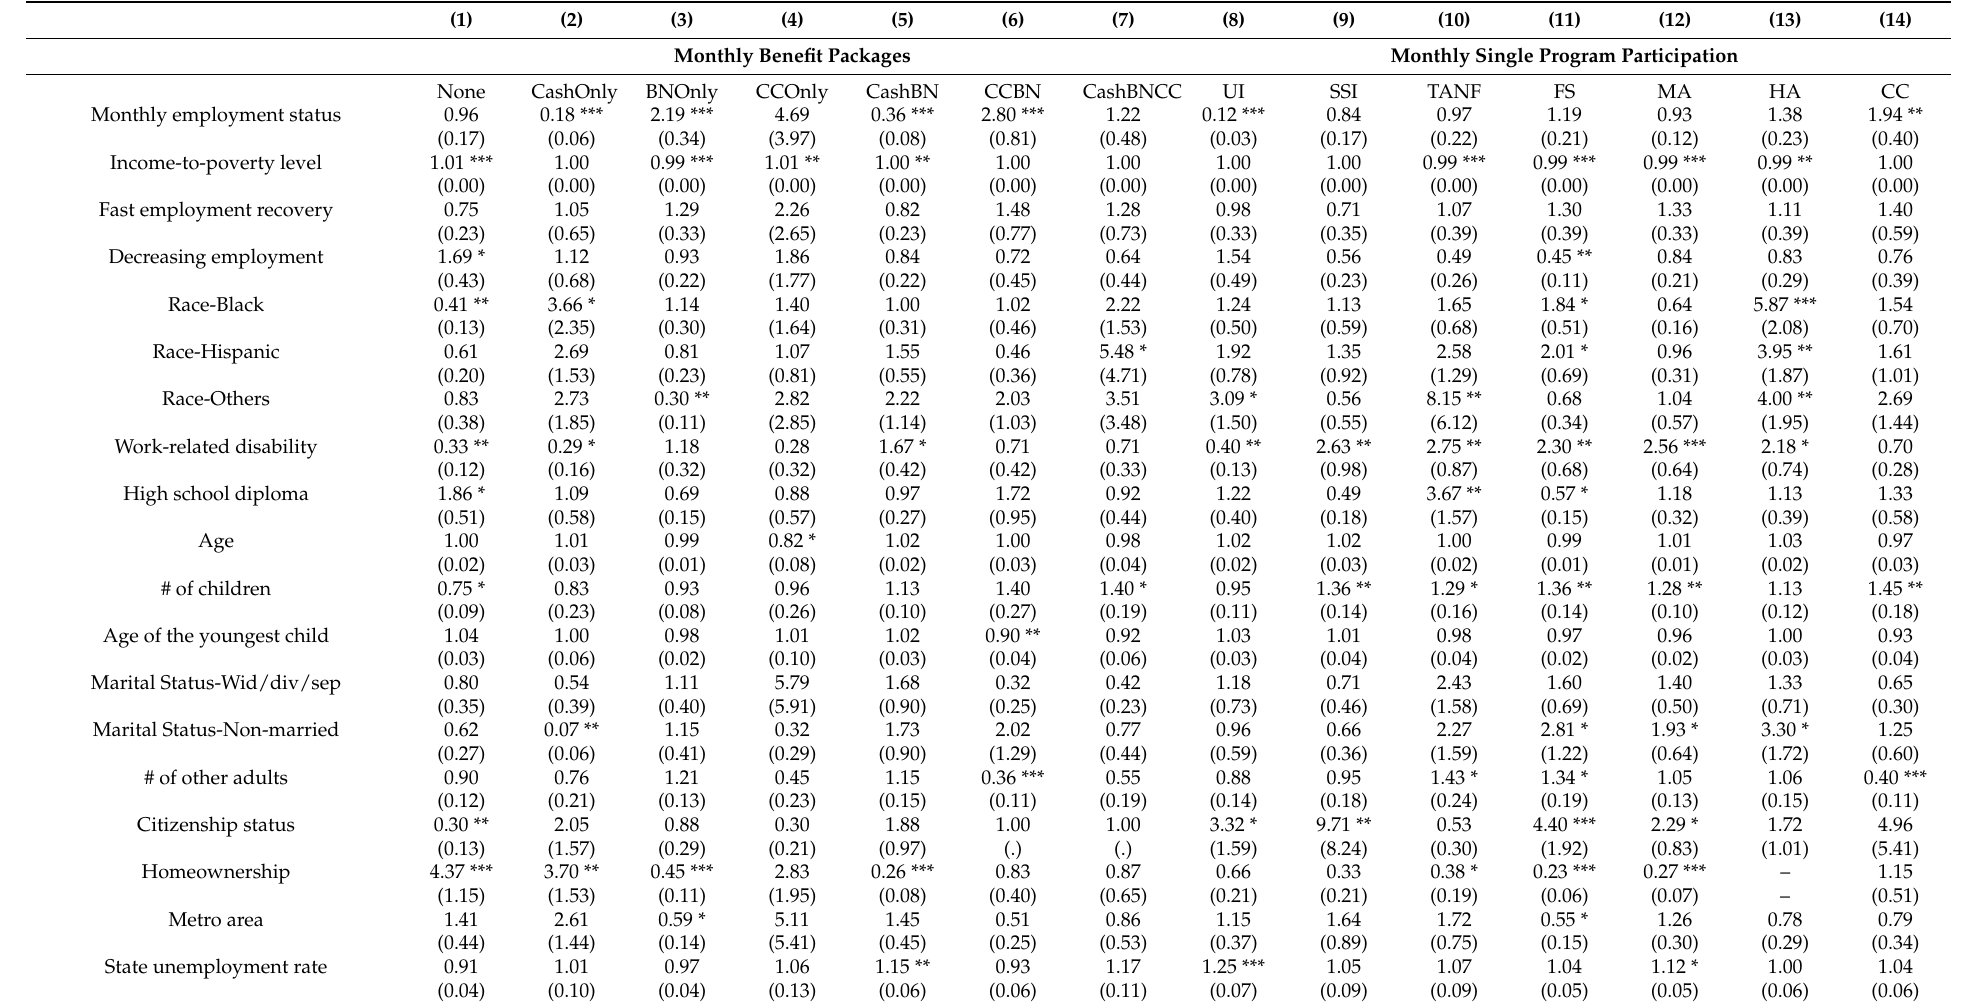
Table 3. Results of the Logistic Regression